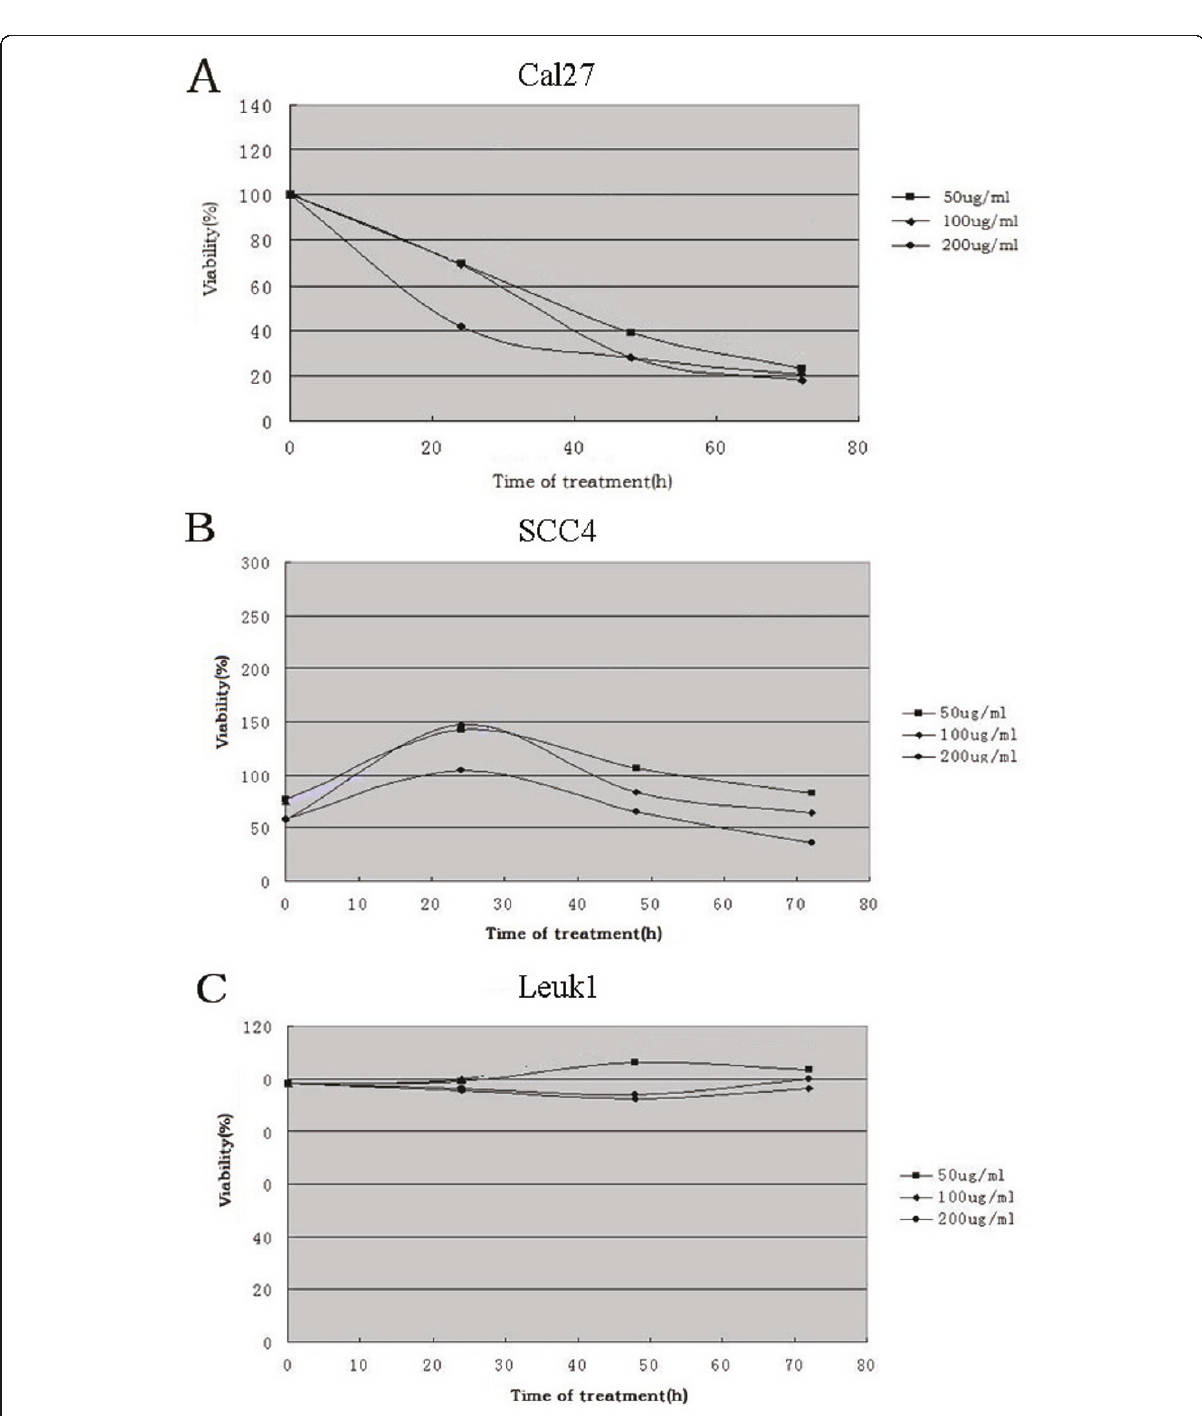
Figure 1 Effects of Sal B on growth of human oral squamous cell carcinoma cells CAL27, SCC4 and oral precancerous cells Leuk1 . Cells (1 × 10 4 ) were treated with increasing concentrations of Sal B (50, 100,200 μ g/mL) for 72 h. Viable cells were measured by MTT assay and expressed as a percentage of control. All values are means of three independent experiments ± SD ( bars ). Time-dependent growth inhibition was seen in CAL27 cells. The SCC4 cells seemed to be stimulated after 24 h, but moderate inhibited at higher concentration after 48 h and inhibited after 72 h. No growth inhibition was also seen in Leuk1 cells. The significance of results obtained from the control and treated groups was analyzed using the paired Student ’ s t-test. Means and standard deviations were calculated. P < 0.05 was regarded as statistically